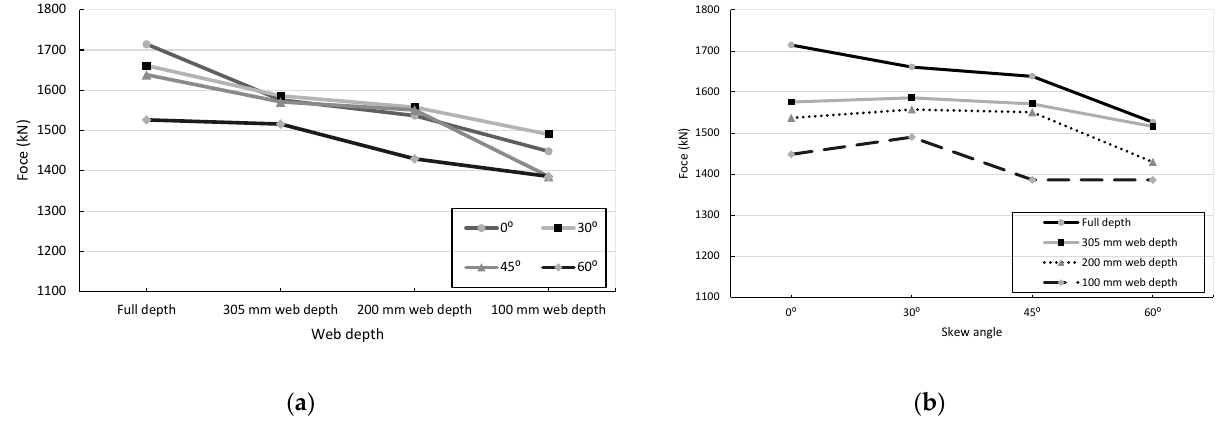
Figure 12. Effect of varying the beam web height and skew angle on the reaction force: ( a ) Effect of web height on the reaction force; ( b ) Effect of skew angle on the reaction force.